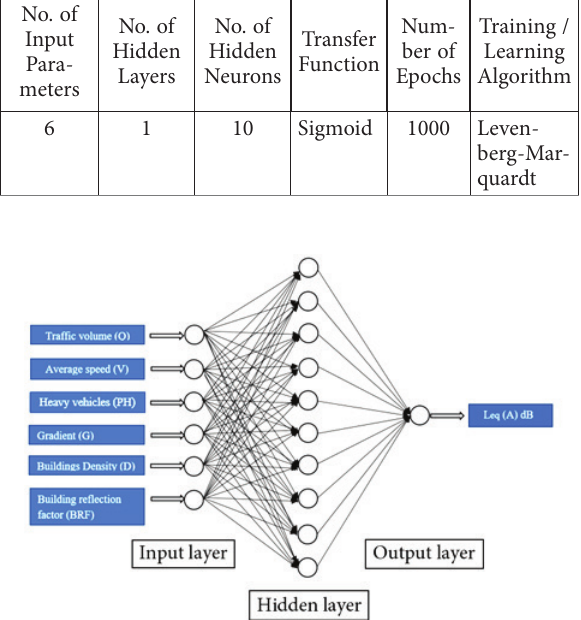
Table 6. Optimal Architecture of Neural Network